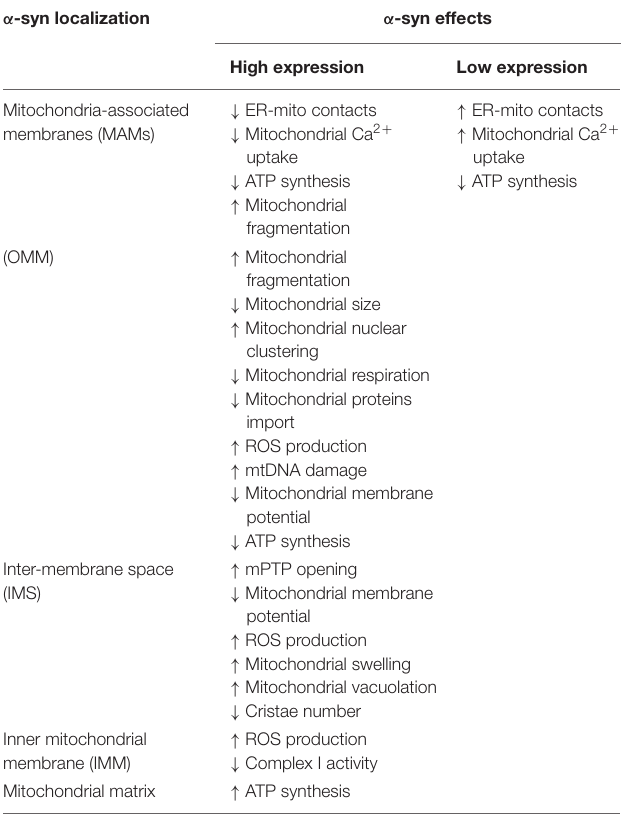
TABLE 1 | Effects of the different sub-mitochondrial α -syn localizations on mitochondrial